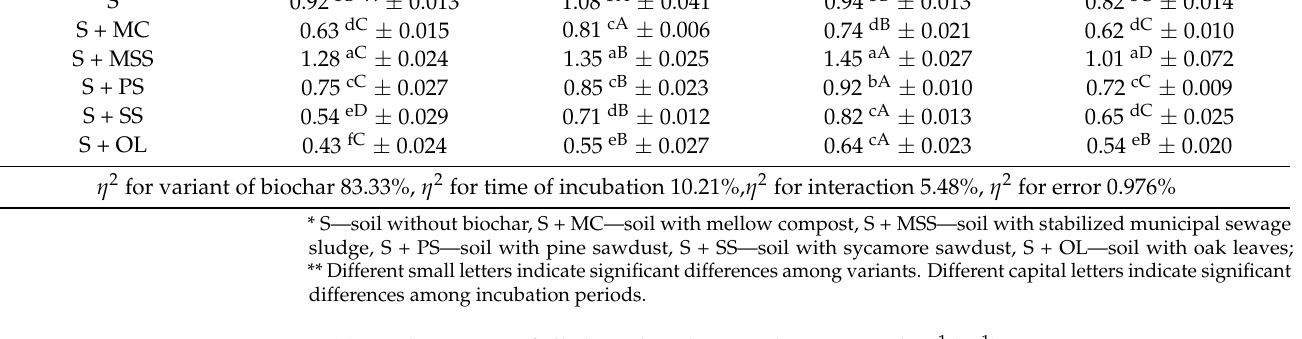
Table 6. The activity of alkaline phosphatase AlP (mMpNP kg − 1 h − 1